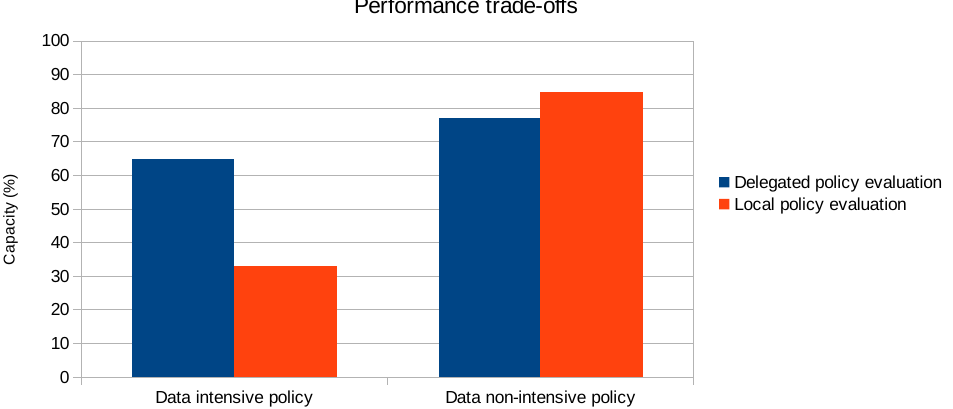
Figure 16. Performance trade-offs of delegated policy evaluation vs. local policy